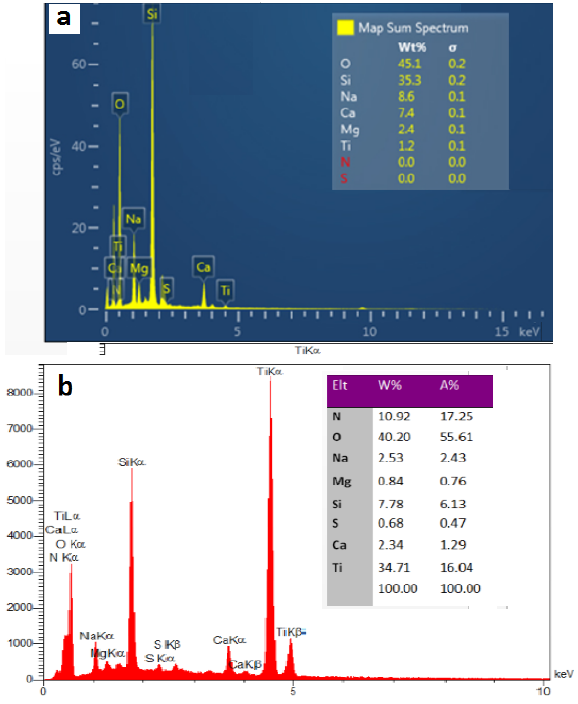
Figure 4. EDX analysis a: TiO